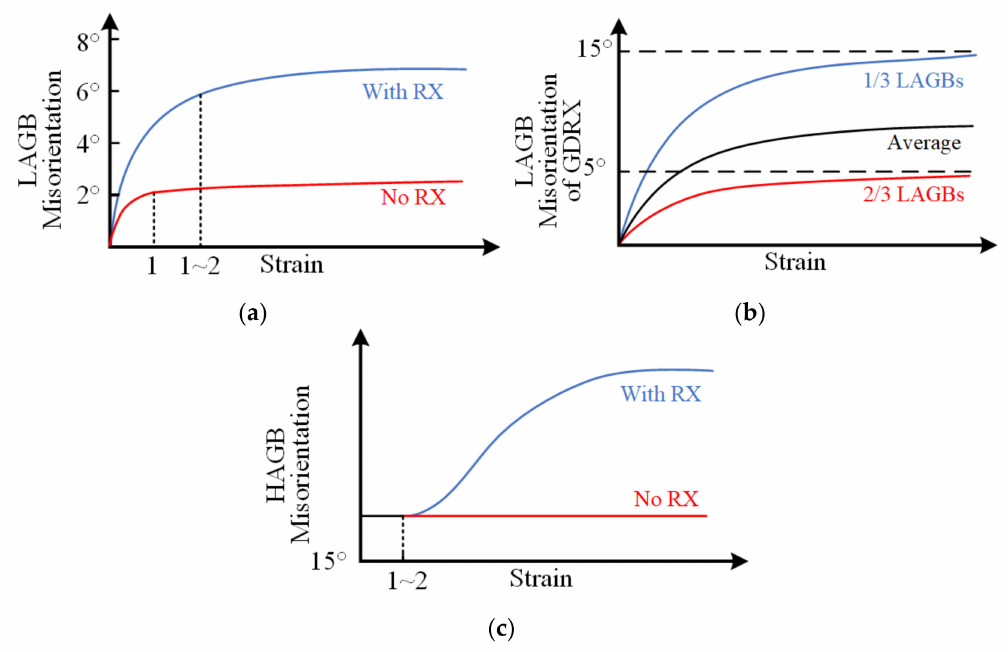
Figure 9. Schematic illustration of ( a ) LAGB misorientation evolution with or without DRX, ( b ) detailed LAGB misorientation evolution in GDRX and ( c ) HAGB misorientation evolution with or without